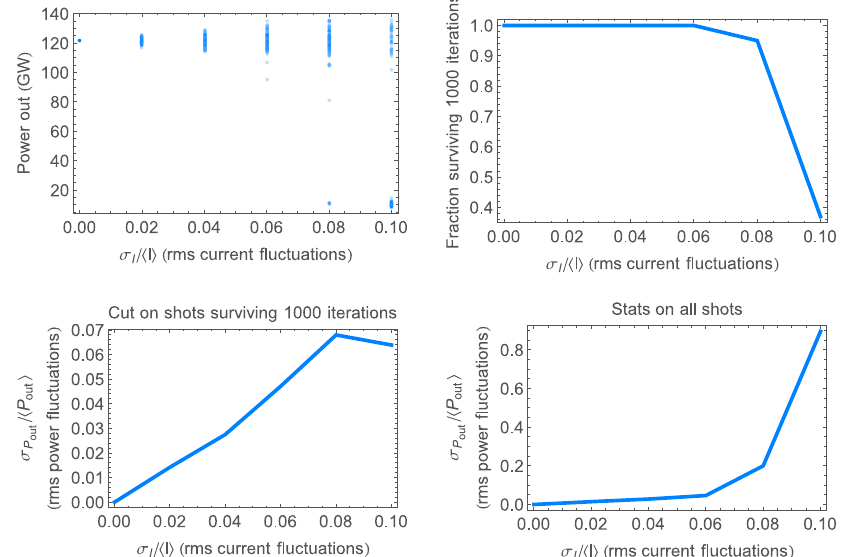
FIG. 15. Results of Monte Carlo simulations for 35% return power fraction and various current fluctuations over 1000 iterations between subsequent ignitions. Top left: power output after 1000 iterations for various rms relative current fluctuations. Top right: fraction of ensemble surviving 1000 iterations. Bottom row: rms relative power variation after 1000 iterations for oscillations surviving 1000 iterations (left) and for all